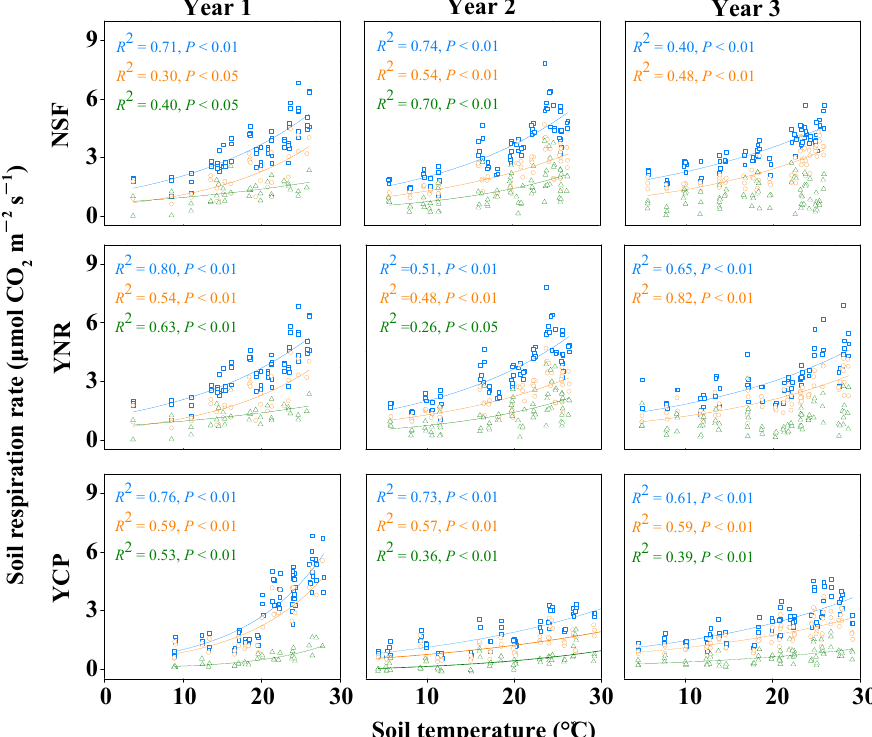
Figure 5. The relationship between soil respiration (Rs, open squares and blue lines), heterotrophic respiration (Rh, open circles and red lines), and autotrophic respiration (Ra, open triangles and green lines) rates and soil temperature during the first three years of sampling time following a reforestation experiment. The fitted curves in the graph all reach the significant level ( p < 0.05). NSF: natural secondary forest, YNR: young forest established via assisted natural regeneration, YCP: young Castanopsis carlesii plantation. Table 2. The temperature sensitivity (Q 10 ) of total soil respiration (Rs), soil heterotrophic respiration (Rh), and soil autotrophic respiration (Ra).